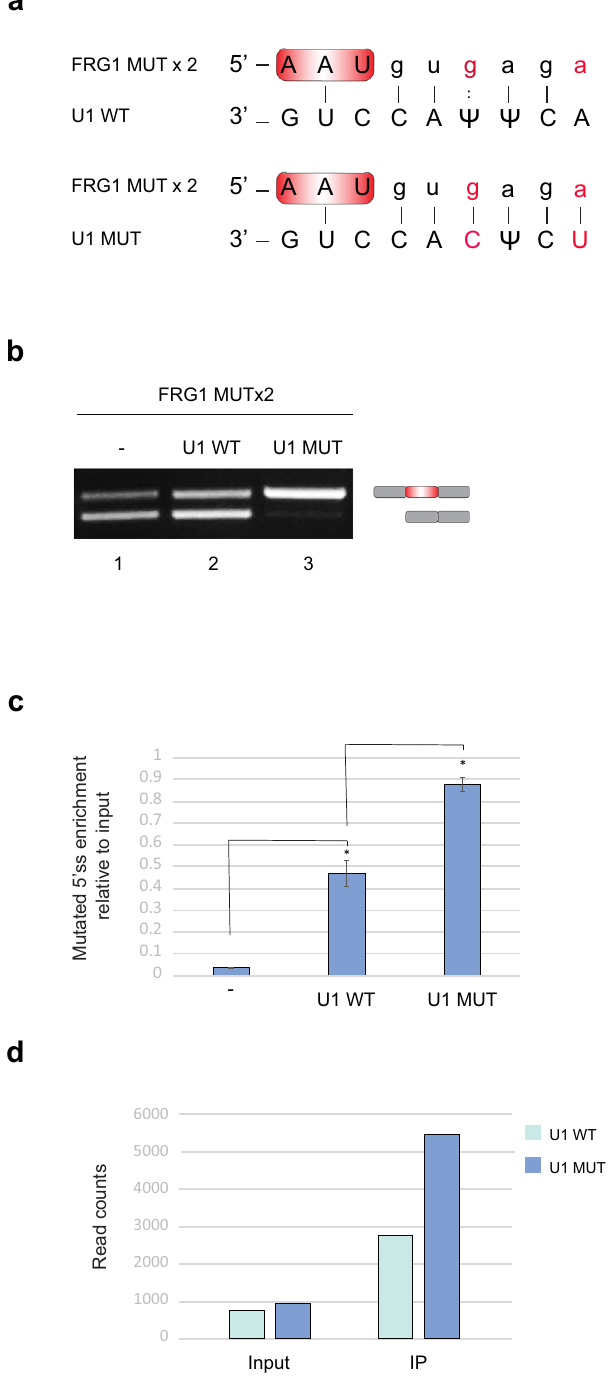
Fig. 3 The U1 snRNA-5 ′ SS-pol II interactionlocated in the middle of an intron is necessary for splicing. a Base pairing interaction between the mutant FRG1 (A to G and T to A at positions + 3 and + 6 in the second 5 ′ SS, termed FRG1 MUTx2) and WT and MUT U1. A full line and colon